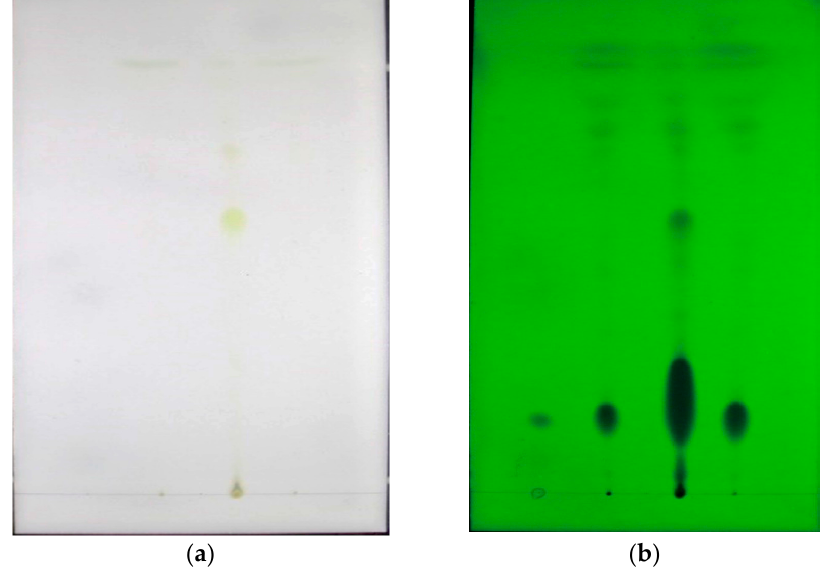
Figure 2. PEE, EEE, and E-PEE TLC (,the sample points in the two TLC plates, from left to right, are standard hydroxyl- α -sanshool, PEE, EEE, and E-PEE, respectively, ( a ) was captured in natural light, ( b ) was taken in UV